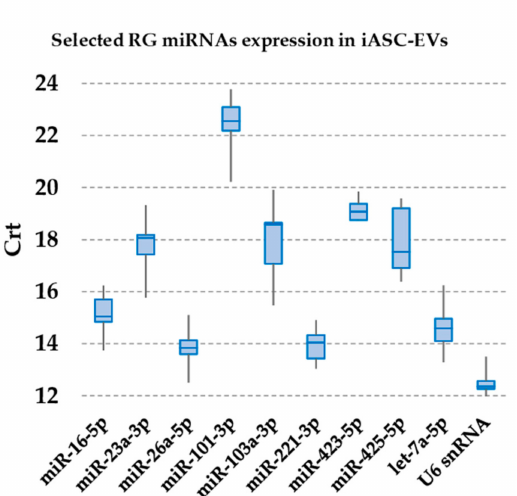
Figure 2. Expression of candidate RG miRNAs in iASC-EVs. The box plot graphs of the Crt values for each RG illustrate the interquartile range (box) and median. The whisker plot depicts the range of the